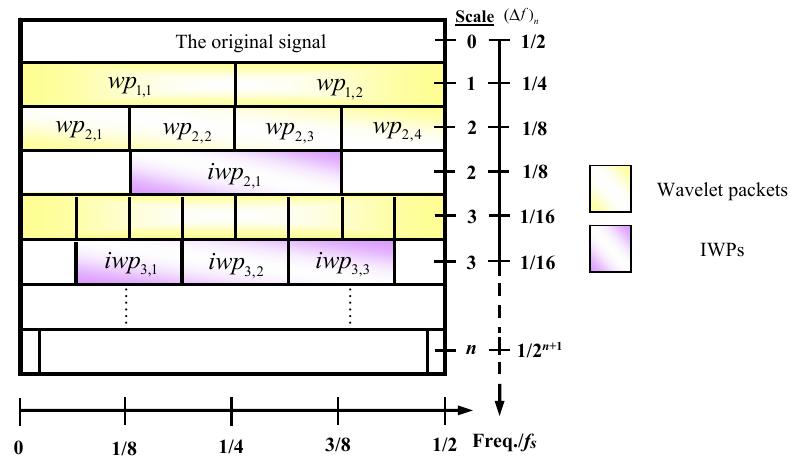
Figure 8. Frequency-scale representation combining wavelet packets and IWPs.